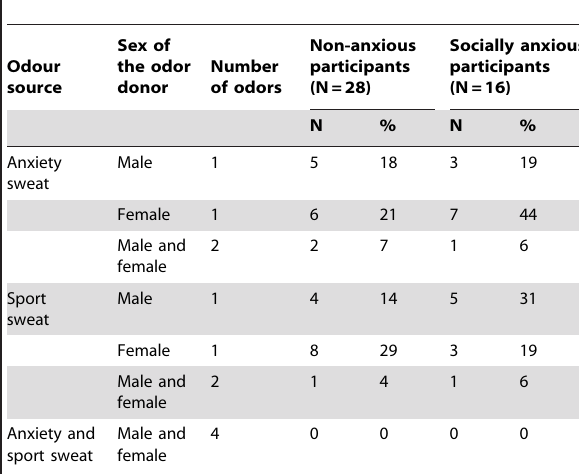
Table 1. Odor detection performances (number/